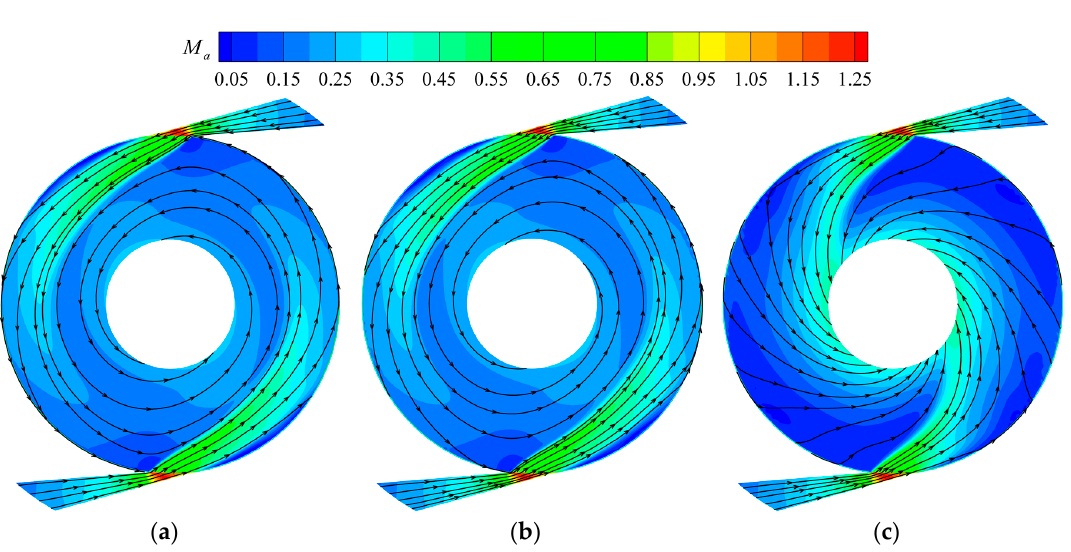
( b ) Figure 9. Contours of relative tangential velocity and vector distributions on radial cross-sections of 0° for the one-to-one Tesla turbine cases at 30,000 r/min: ( a ) Case 1-0.5; and ( b ) Case 2-0.5. 3.2.2. One-To-One Turbine with Different Disc Spacing Distance To reveal the detailed flow characteristics in the disc channels of the one-to-one turbine with different disc spacing distance, Figure 10 shows the variation curves of circumferential mass flow